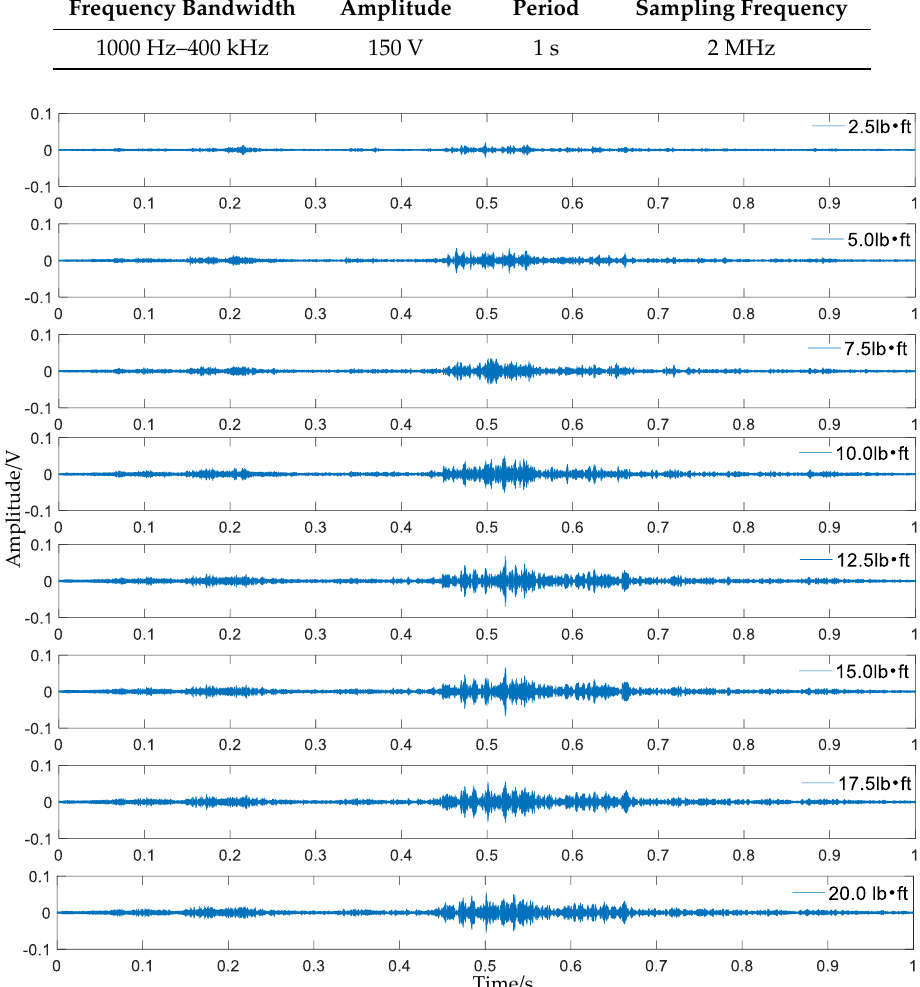
Table 3. Parameters of the swept sine wave.